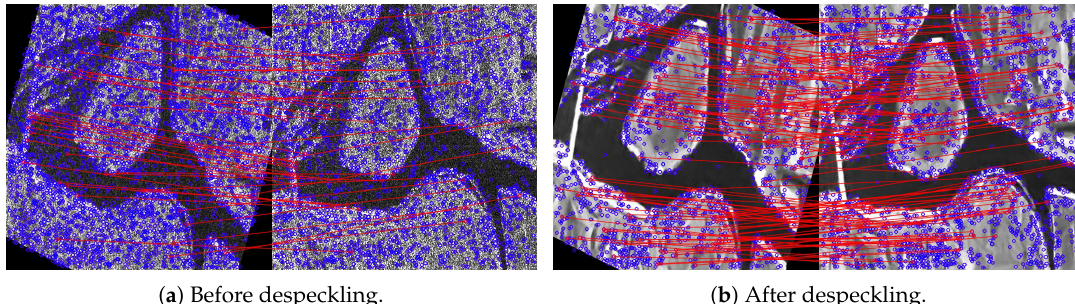
( b ) After despeckling.